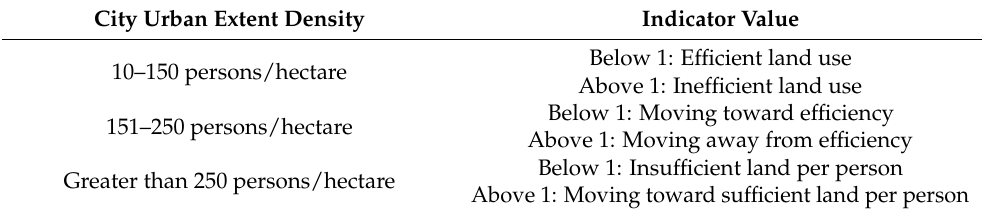
Table 2. Classification of the LCRPGR values proposed by